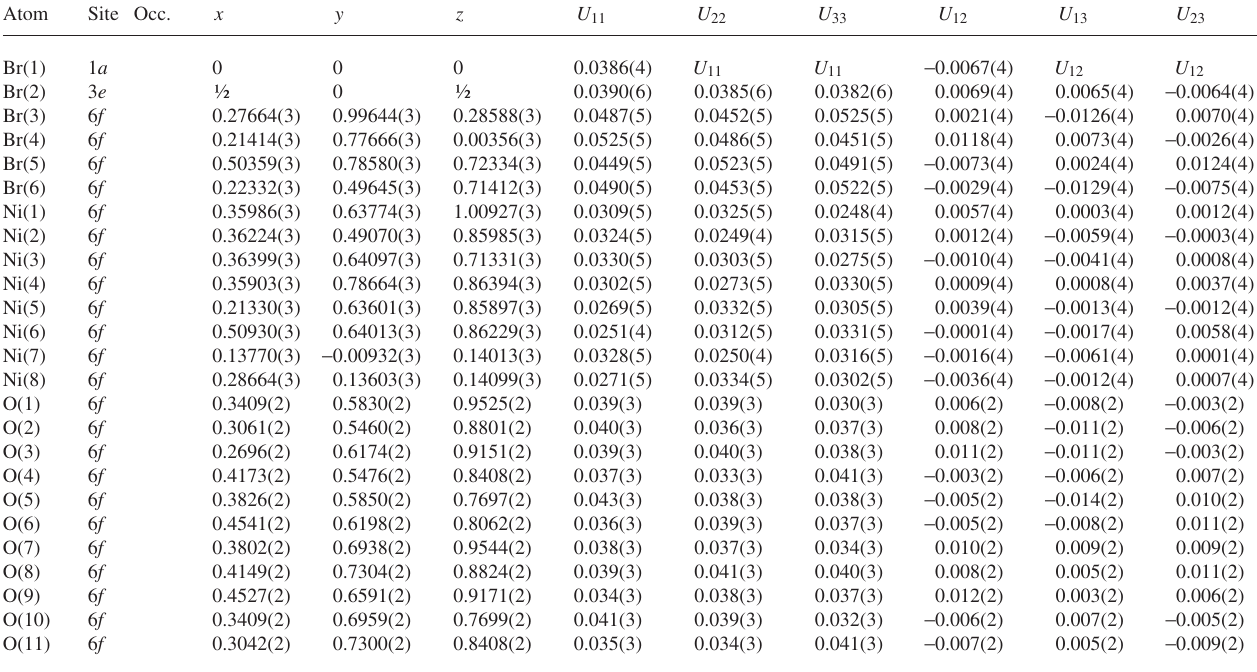
Table 3. Atomic coordinates and displacement parameters (in Å 2 ) . Atom Site